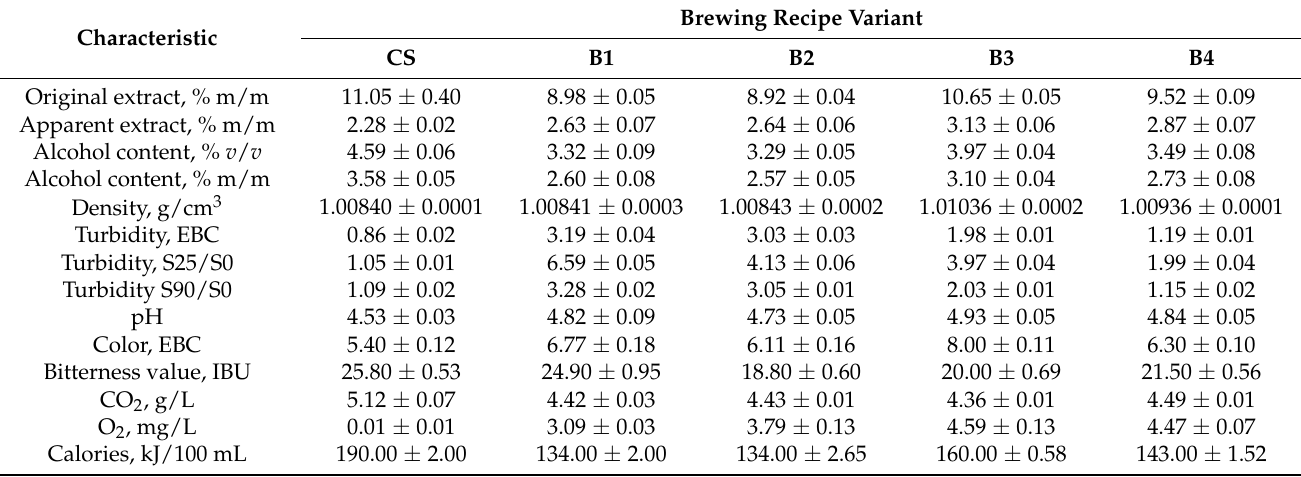
Table 8. Physico-chemical characteristics of beer final